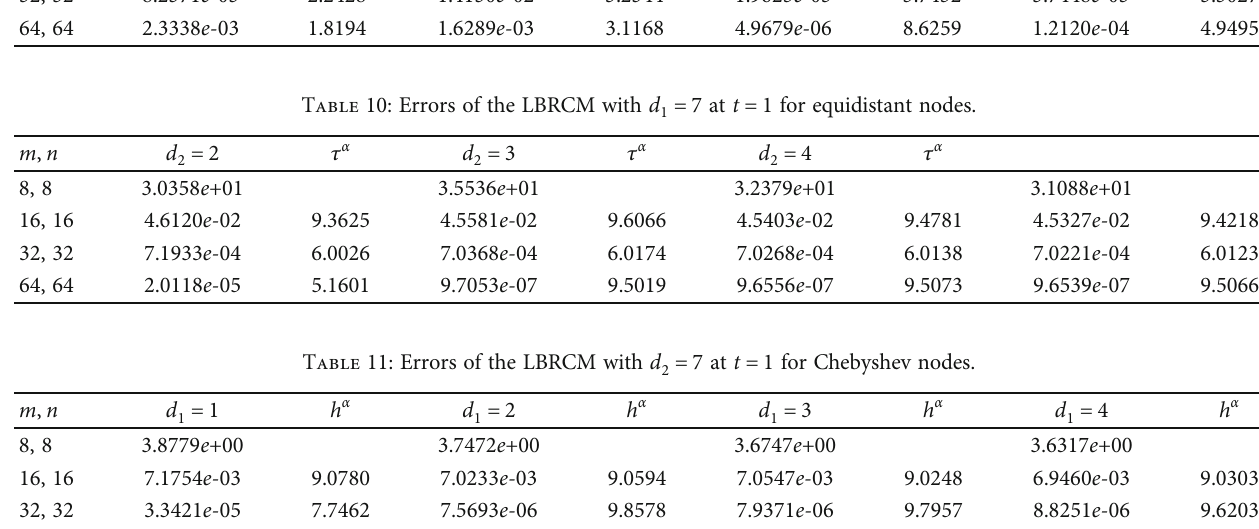
Table 12: Errors of the LBRCM with d